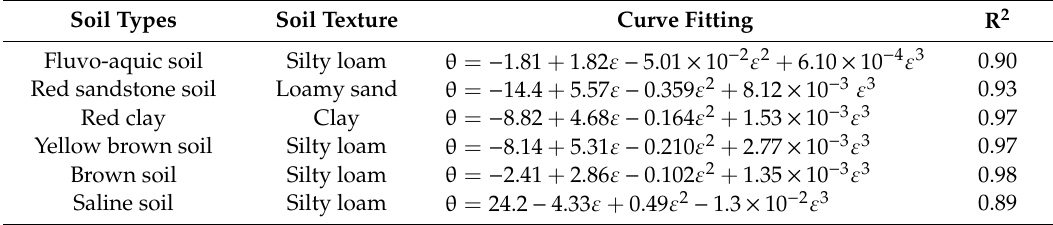
Table 4. Fitting curves between the dielectric constant and SWC for different soil types.